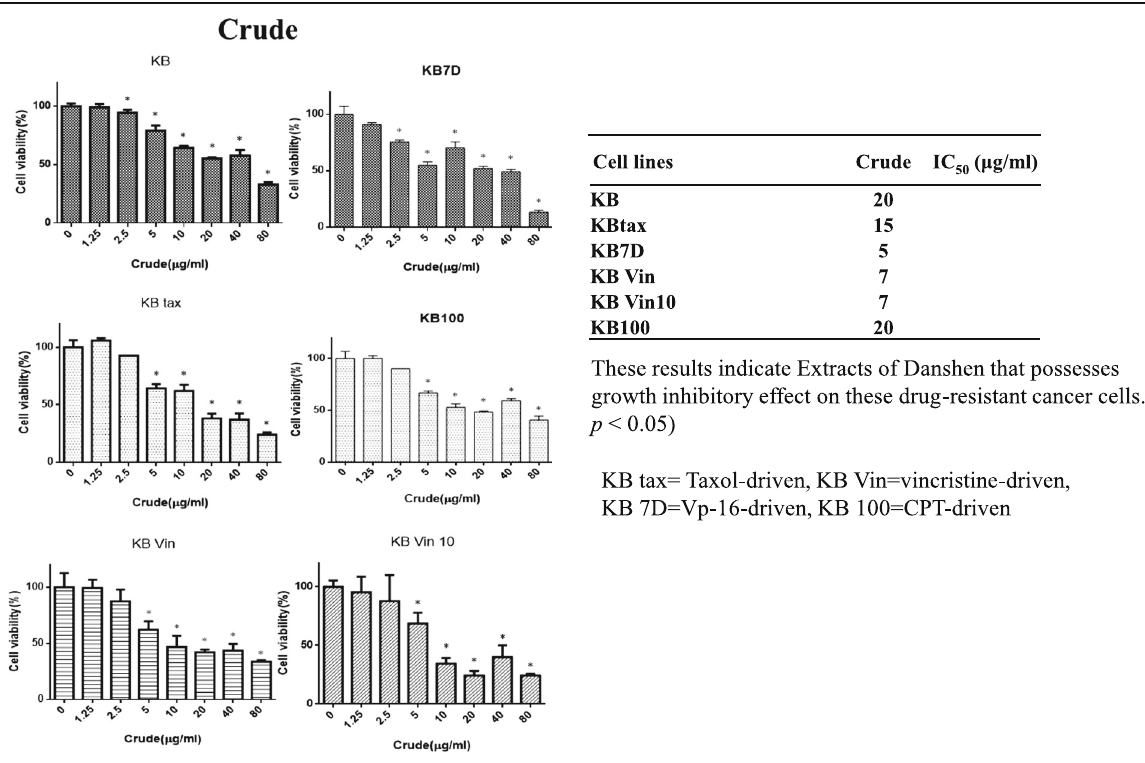
Fig. 7 Inhibition of drug-resistant KB cell growth in vitro via the Danshen crude. An assessment of cell proliferation and viability by using the methylene blue assay in six drug-resistant oral cancer cells treated with varying concentrations of the Danshen crude (0 – 80 μ g/mL) or dimethyl sulfoxide (1 μ L/mL) for 24